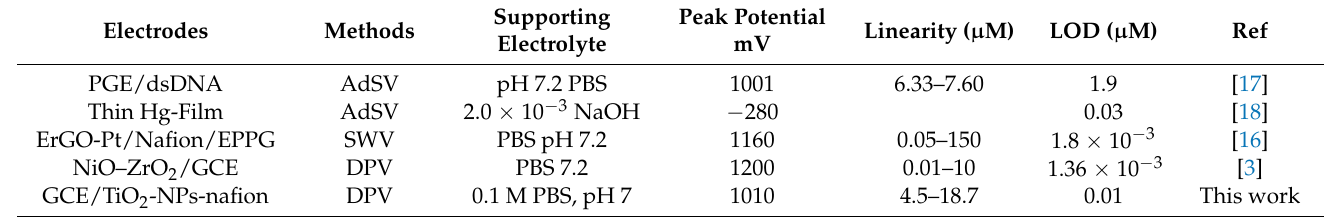
Figure 8. ( A ) GCE/TiO 2 -NPs-nafion response to increasing EFV concentrations measured by DPV and ( B ) Linear plot of I pa against concentrations (4.5 to 18.7 µM) in PBS. Table 5. Comparison present sensor with reported sensors.